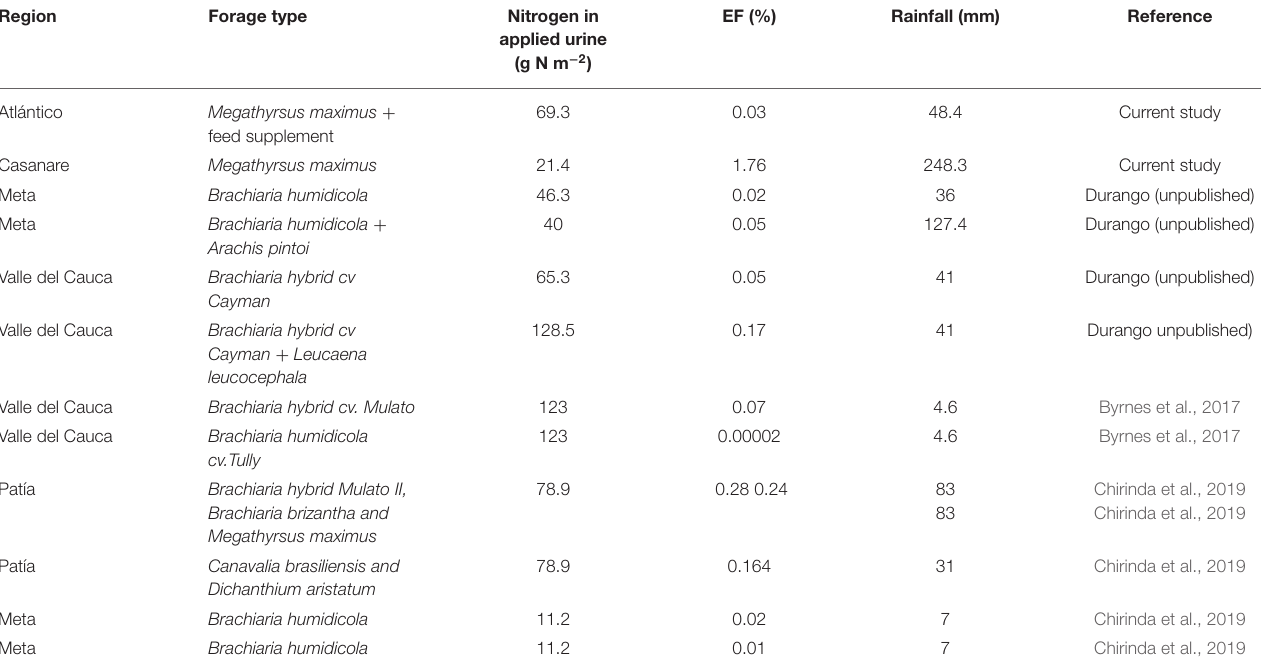
TABLE 3 | Soil urine derived N 2 O-N EF for studies conducted at different sites in Colombia. Region Forage type Nitrogen in